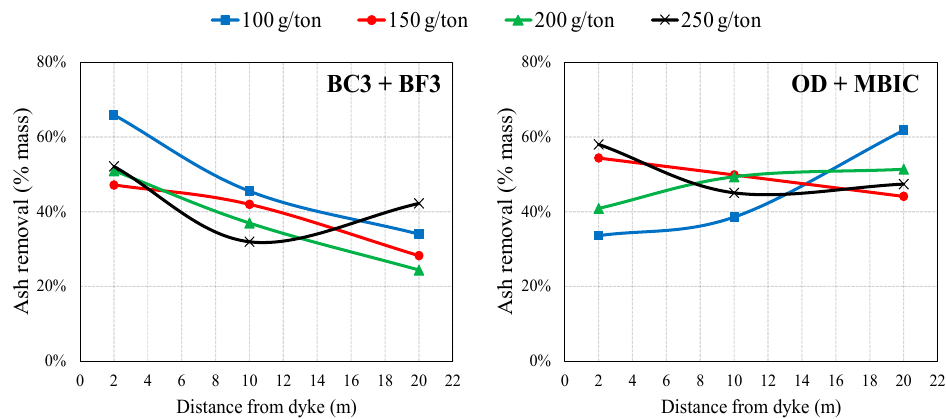
Figure 10. Ash removal indexes in function of distance from dyke for each reagent system tested.